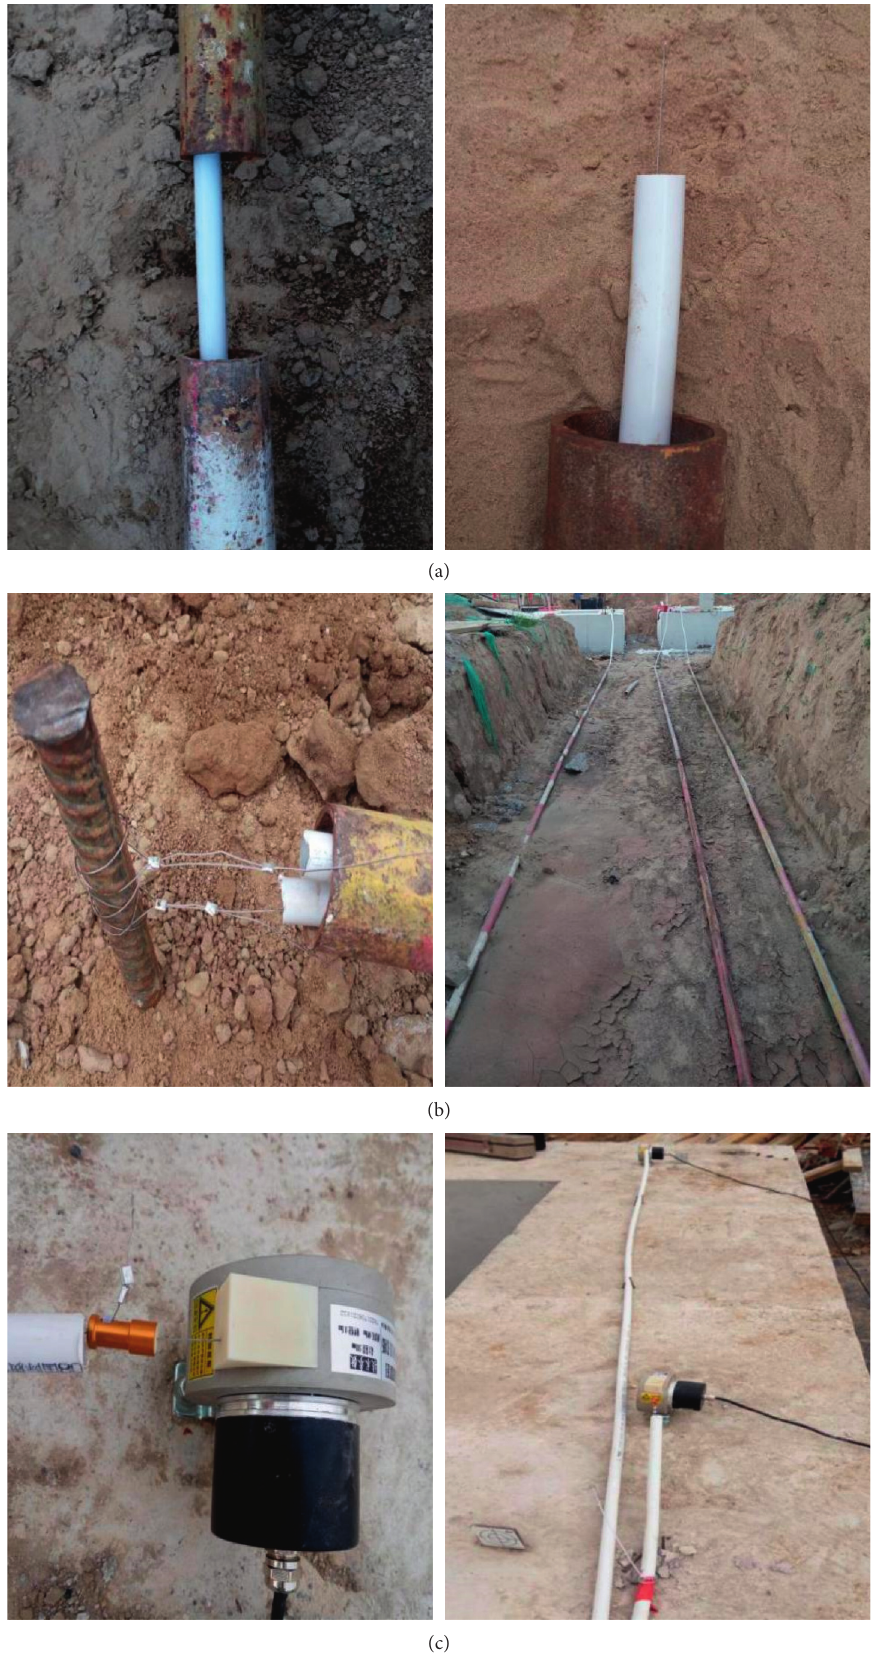
Figure 10: Connection diagram of the remote displacement automatic monitoring system. (a) Relative position of the aluminum-plastic tube, iron pipe, and steel strand. (b) Fixed point connection behind the pile. (c) Connection of guyed displacement gauge on the pile